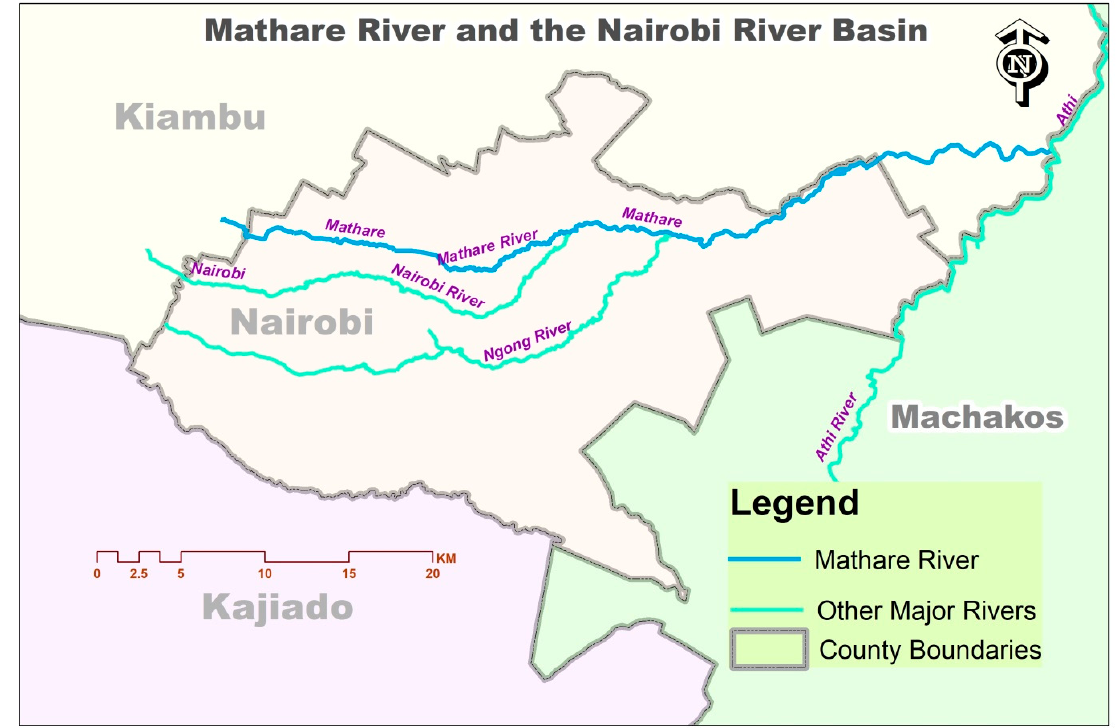
Figure 4. River connects landscapes in different counties (Source: authors).